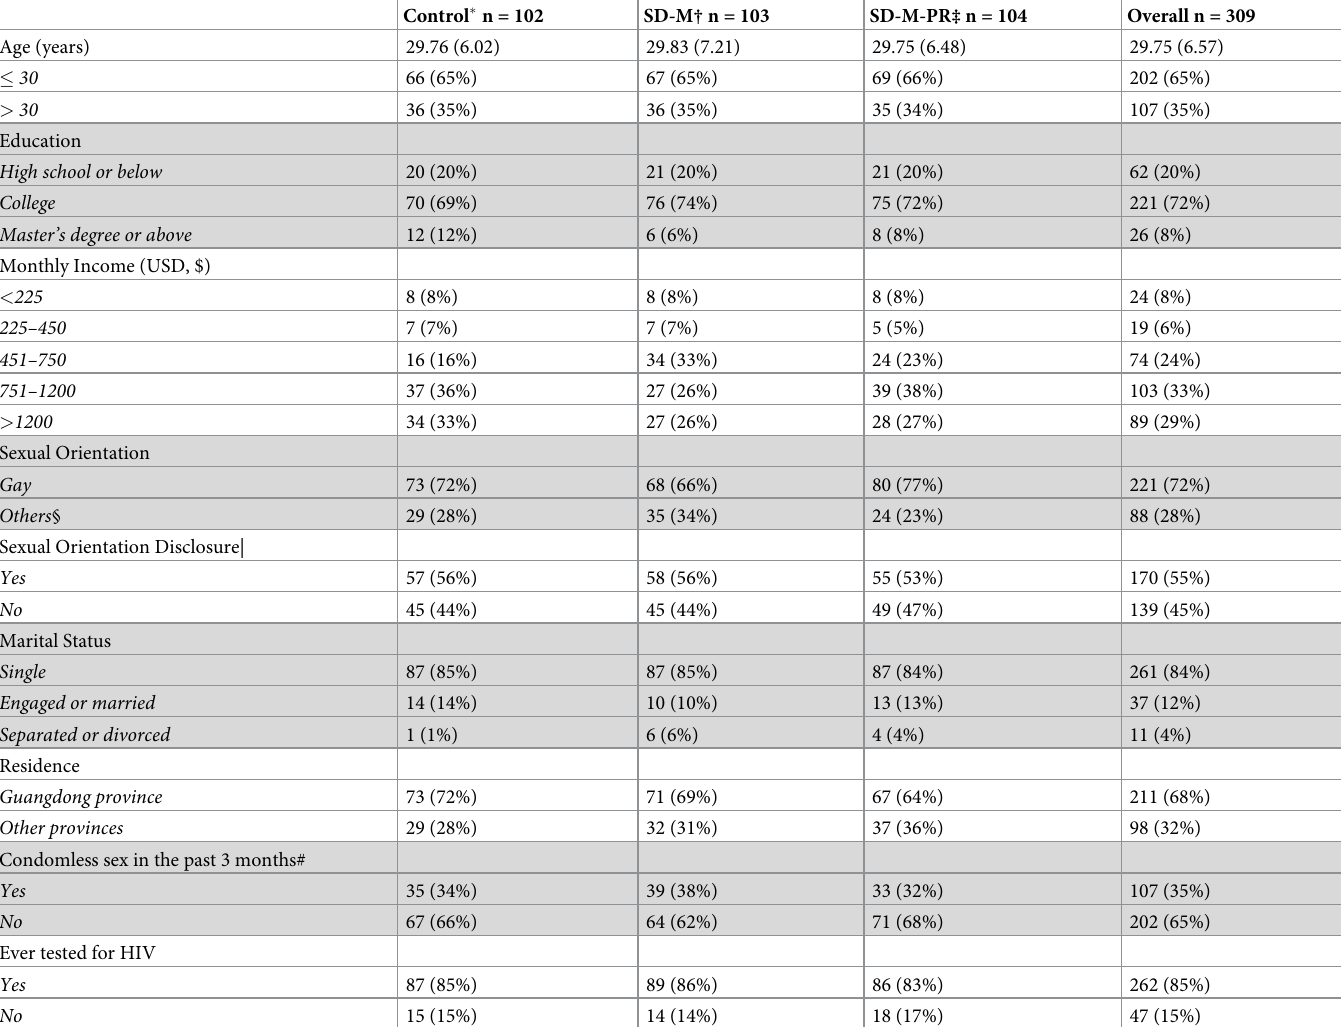
Table 1. Baseline characteristics of the index participants in Zhuhai, China, 2019 to 2020 ( N =